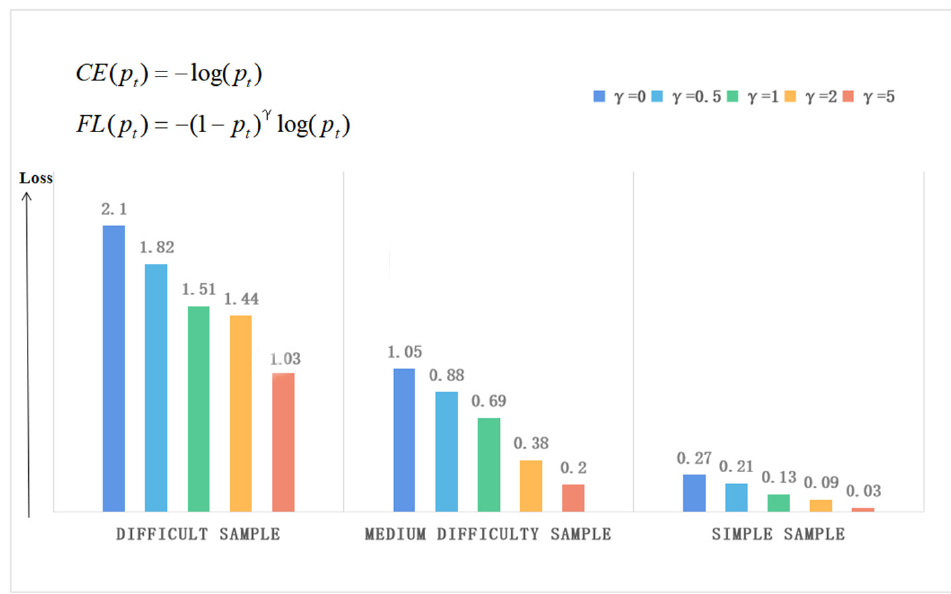
Figure 4. Weight loss function change fi gure.